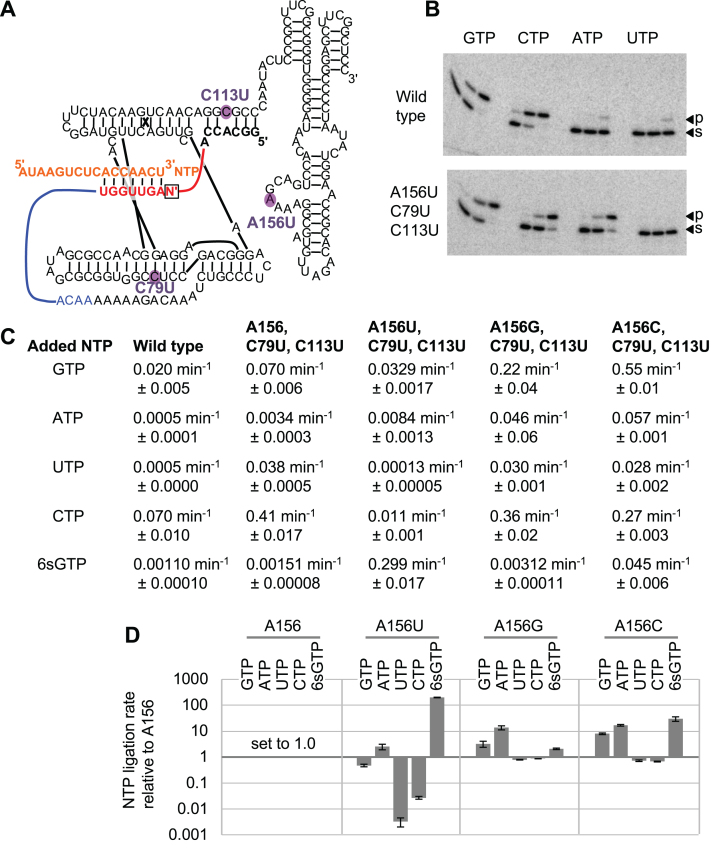
Influence of mutations in the polymerase ribozyme on the ligation kinetics of canonical NTPs and 6sGTP. (A) Secondary structure representation of the polymerase ribozyme constructs used for this assay. The three positions differing between wild type and triple mutant are highlighted in purple, with a purple label showing the mutation. The primer (orange) is base paired to the template strand (red) and is extended by the incoming NTP (red). In each experiment, the templating nucleotide (boxed) is adjusted to form a Watson–Crick pair with the NTP. The sequence linking the R18 polymerase ribozyme 5′-terminus with the template 3′-terminus is shown in blue, and the red line shows the connection between template 5′-terminus and the 3′-terminus of the 5′-GGCACCA sequence in the P2 stem. (B) Autoradiogram of radiolabeled ligation products that were separated by denaturing 10% PAGE. The NTPs used for each reaction are shown on the top. The three lanes for each NTP stem from samples with the incubation times of 2, 20 and 180 min. The lower band (labeled with ‘s’ on the right) is the substrate, the upper band (p) is the product, which is one nucleotide longer than the substrate. The upper and lower audioradiogram show the signals from the wild type sequence and the triple mutant A156U/C79U/C113U, respectively. (C) Observed kinetic rates determined from triplicate experiments as shown in B, using single-exponential curve fitting to quantified data. (D) NTP ligation rates relative to the variant A156/C79U/C113U. All variants contain the C79U and C113U mutation, and only the nucleotide in position 156 is varied. The NTP used for each experiment is given above each column. Error bars correspond to standard deviations from triplicate experiments.